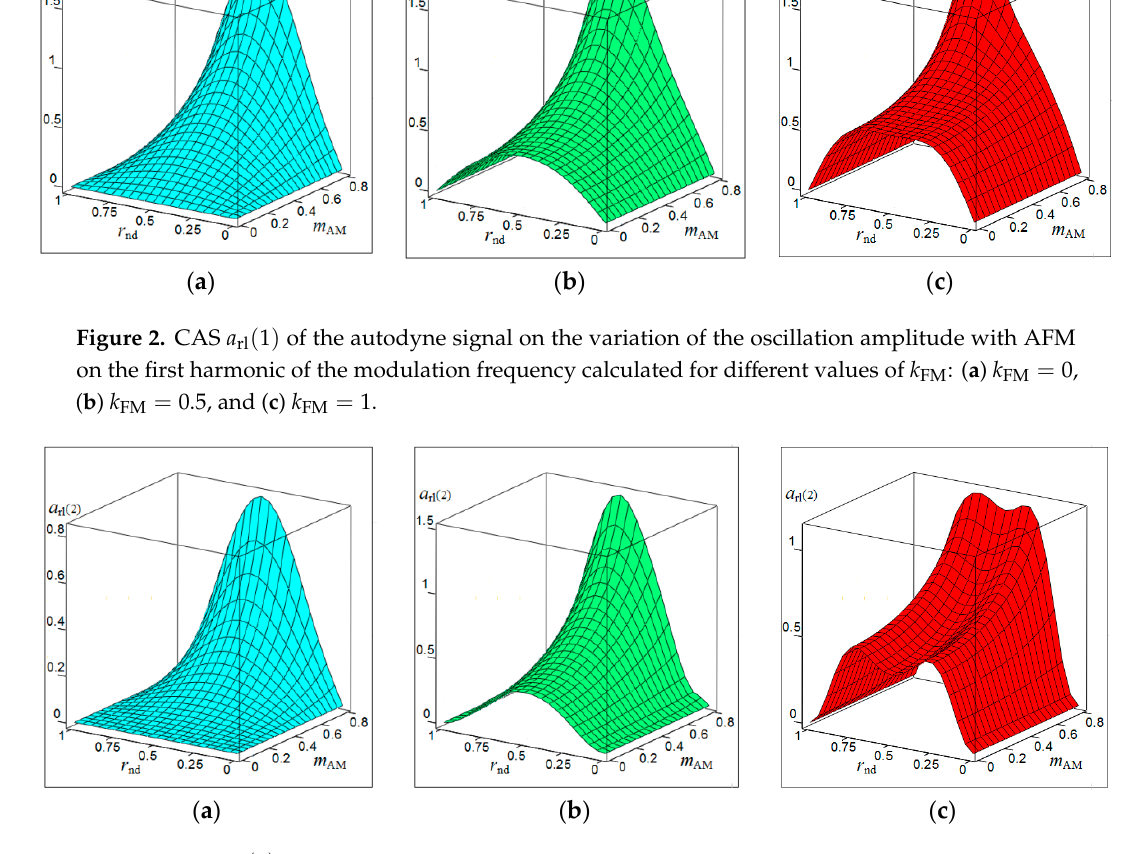
Figure 3. CAS a rl ( 2 ) of the autodyne signal on the variation of the oscillation amplitude with AFM on the second harmonic of the modulation frequency calculated for di ff erent values of k FM : ( a ) k FM = 0, ( b ) k FM = 1, and ( c ) k FM = 2.